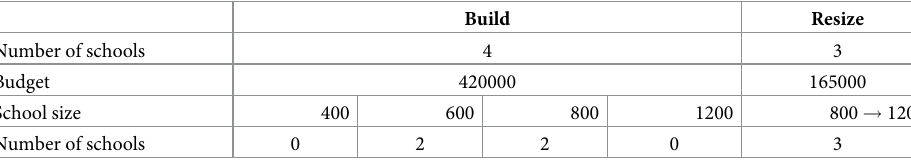
Table 5. Updates in the 2025-2030